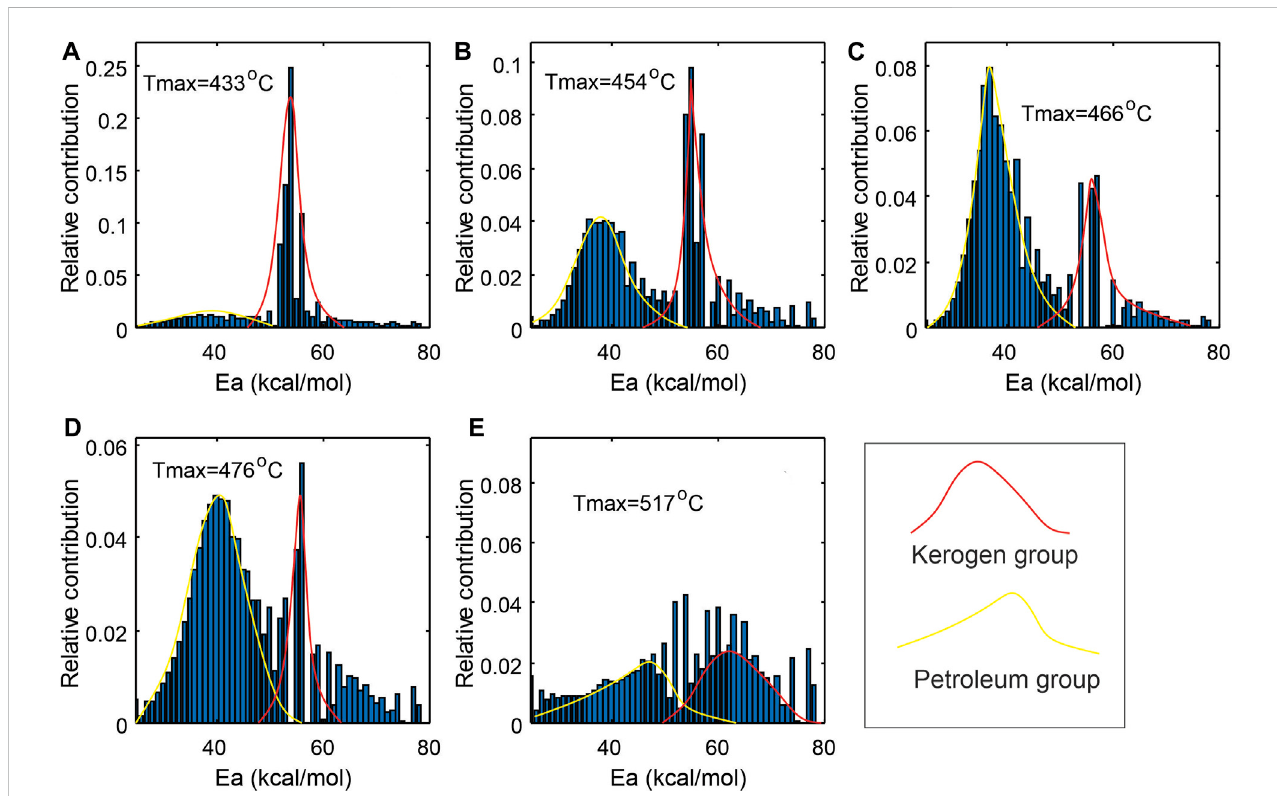
FIGURE 8 PetroleumandkerogencomponentsgroupingbasedonEavaluesderivedfromRock-EvalFIDcurveinanactivationdomain,seeinggrowthinpetroleum and decline in kerogen components with increasing thermal maturity: (A – E) correspond to samples C-590392, C-594351, C-590327, C-590436 and C- 590378 in Table